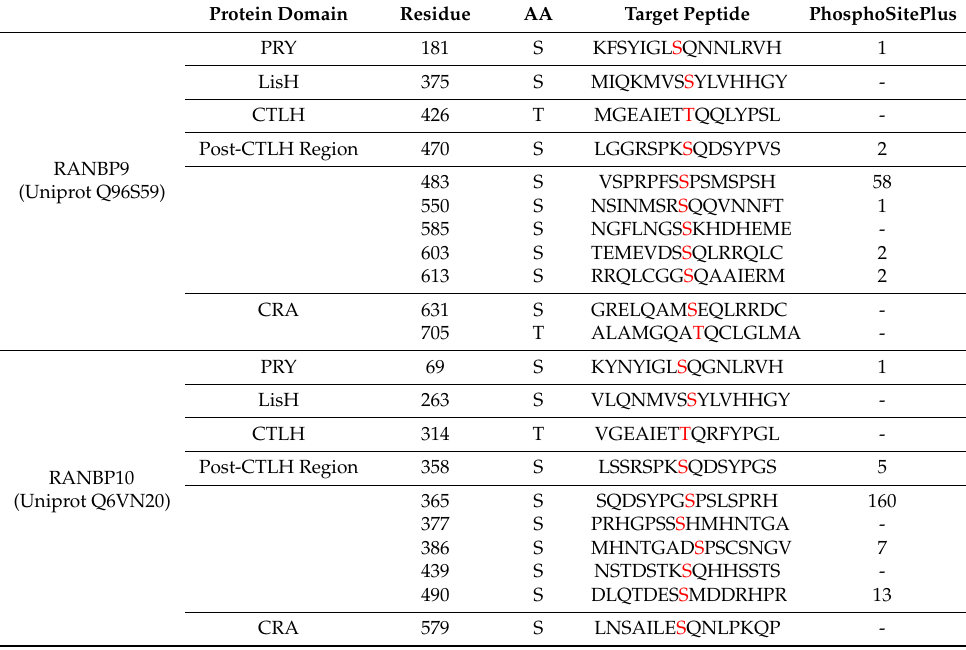
Figure 1. Schematic representation of RANBP9 and RANBP10 proteins. RANBP10 shares high amino acid conservation with RANBP9 in the PRY (94%), SPRY (97%), LisH (82%), CTLH (90%), and CRA (89%) domains. The two proteins differ the most at the N-terminus and in the post-CTLH region, which contains several putative PIK-kinase phosphorylation sites (see Table 1). PRD (red)= Proline-Rich Domain; PRY/SPRY (light blue) = Spore lysis A and Ryanodine receptor Domain; LisH (green) = Lissencephaly type-I-like homology motif; CTLH (yellow) = Carboxy-terminal to LisH motif domain; CRA (orange) = CT11-RanBP9 domain; dark blue = putative Nuclear Localization Signal; Tub (purple) = tubulin-binding domain. Table 1. Phosphorylation sites by ATM, ATR and DNA-PK (PIK kinases) on RANBP9 and RANBP10. Selected list of serines and threonines (Amino acids “AA” column) and target peptides predicted by the algorithm Group-Based Prediction System, GPS 3.0 (http://gps.biocuckoo.org) to be phosphorylated by PIK-kinases on RANBP9 (Protein ID: Uniprot Q96S59) and RANBP10 (Protein ID: Uniprot Q6VN20). Protein domains in which the listed target sites are located are also indicated. Selection of predicted sites was based on a score > 2 and a difference between the score and the threshold >20% of the total score. The only exceptions to these criteria are RANBP9 S483 and RANBP10 S365, whose existence is reported in 58 and 160 datasets, respectively from the “PhosphoSitePlus” website. PhosphoSitePlus column lists associated with those datasets and criteria used for the selection, please visit: www.phosphositeplus.org. Protein